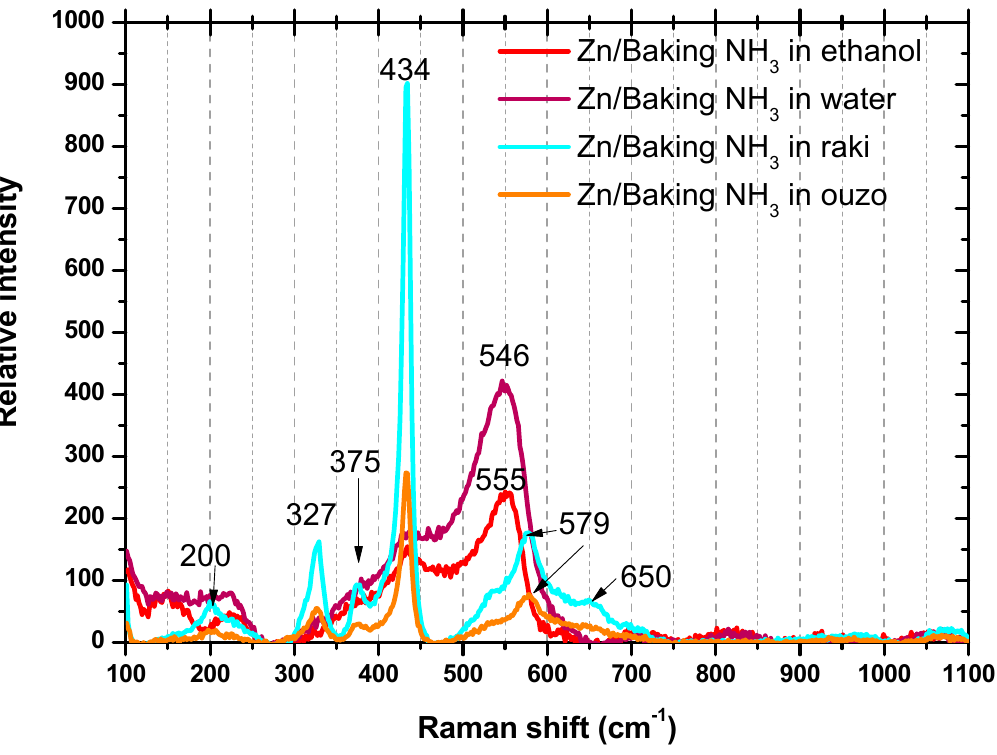
Figure 6. Raman spectra of the ZnO coatings synthesized from eco-friendly precursor materials.